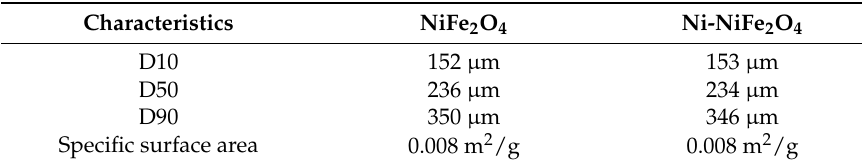
Table 2. Size characteristics of NiFe 2 O 4 and Ni-NiFe 2 O 4